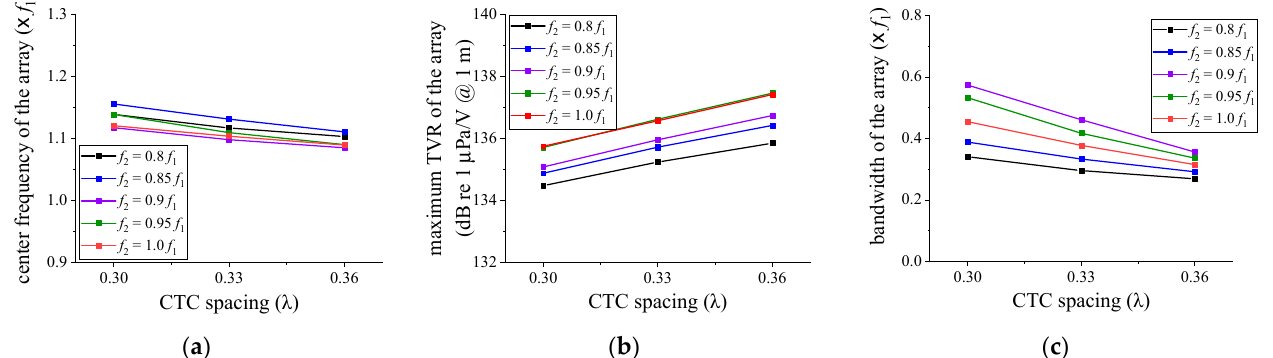
Figure 7. Variations of the acoustic characteristics of the cymbal array in relation to the CTC spacing: ( a ) center frequency; ( b ) maximum TVR level; ( c ) bandwidth.